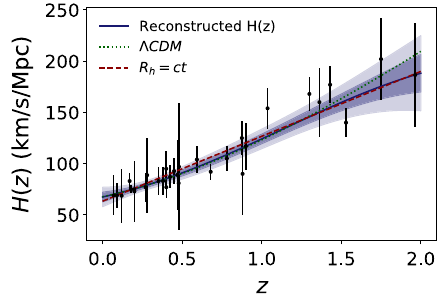
Fig. 1 Plot showing H ( z ) chronometer data along with the best- fit (cid:2) CDM model and the R h = ct model, with best-fit parameters obtained using unbinned data. Also shown is H ( z ) reconstructed non- parametrically (along with 1 σ and 2 σ errors in reconstruction). The reconstruction was done with Gaussian Process Regression using the GaPP package R h = ct universe model. This is obtained by minimizing the χ 2 functional given by: